Question: Which kind of chart has been used to present this data?
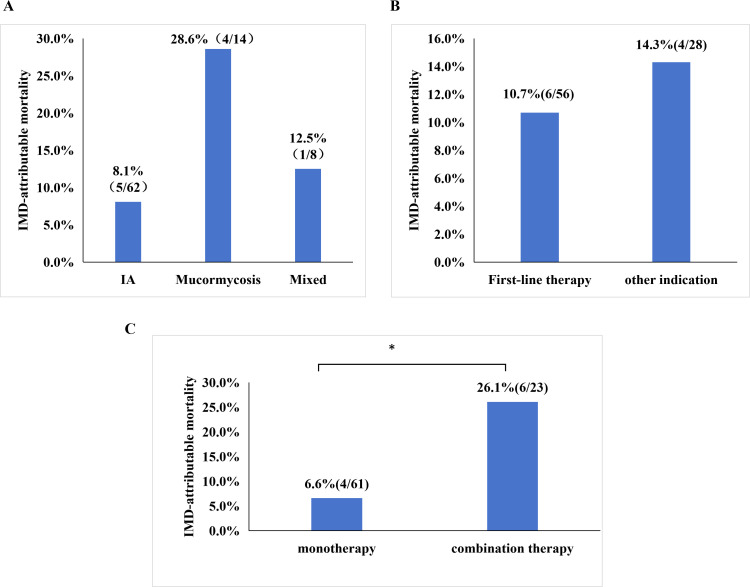
Answer: bar